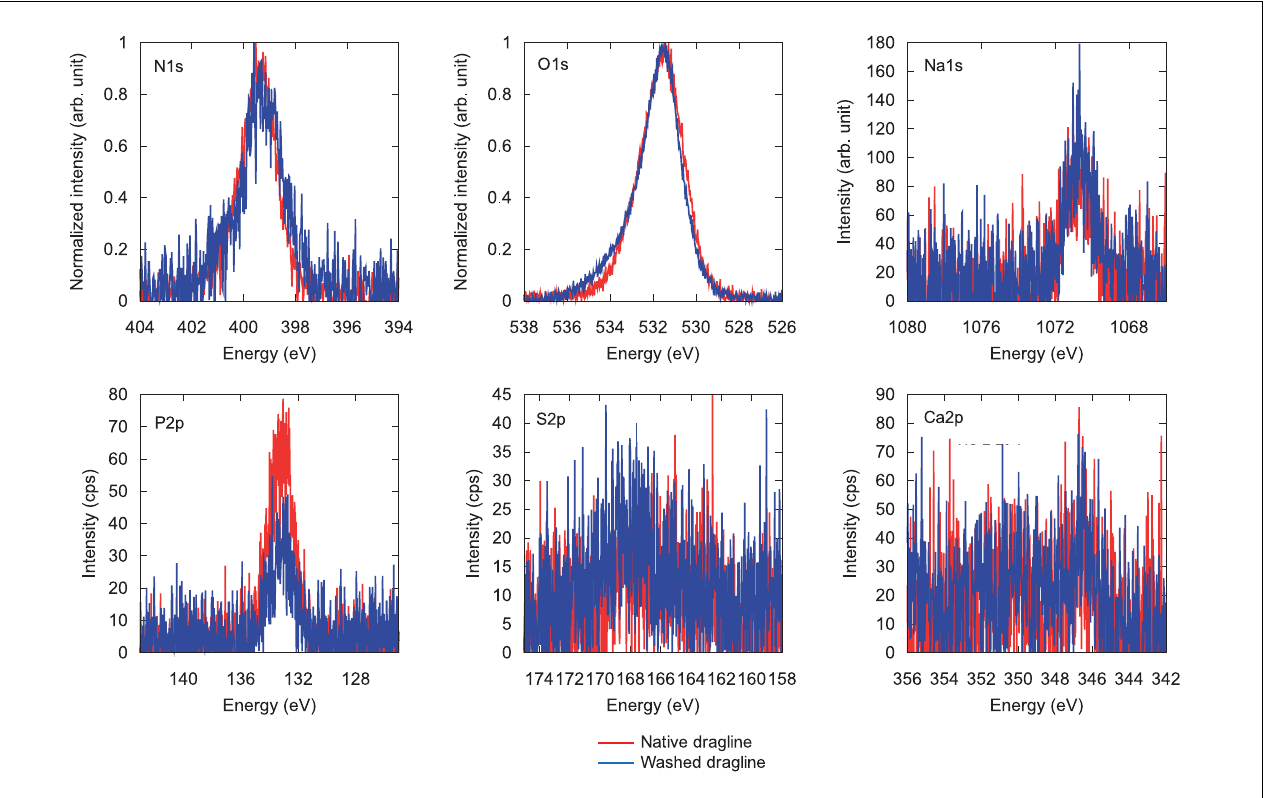
FIGURE 5 | XPS spectra for different elements in native spider dragline (red) and spider dragline after an ether wash (blue). TABLE 1 | XPS characterization of different elements and components of native spider dragline and spider dragline after an ether wash. % (Standard deviation) C 1s C-H